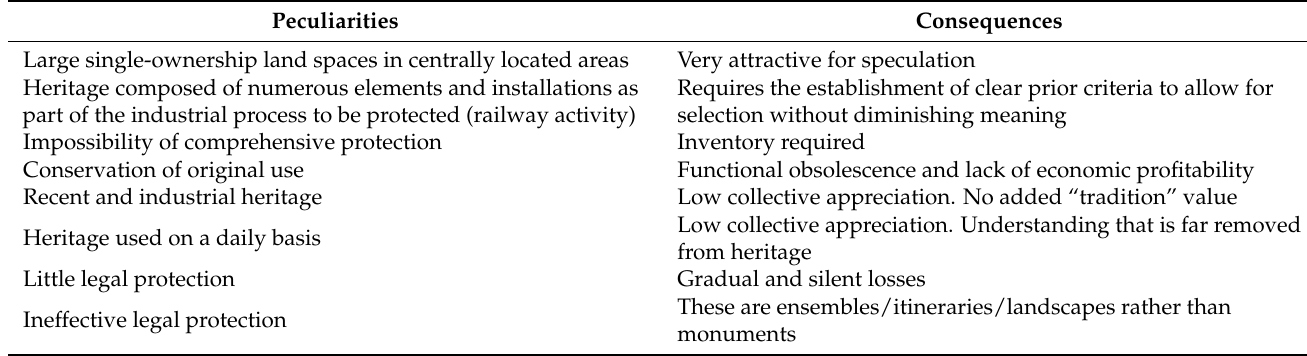
Table 3. Peculiarities/consequences of railway heritage. Own